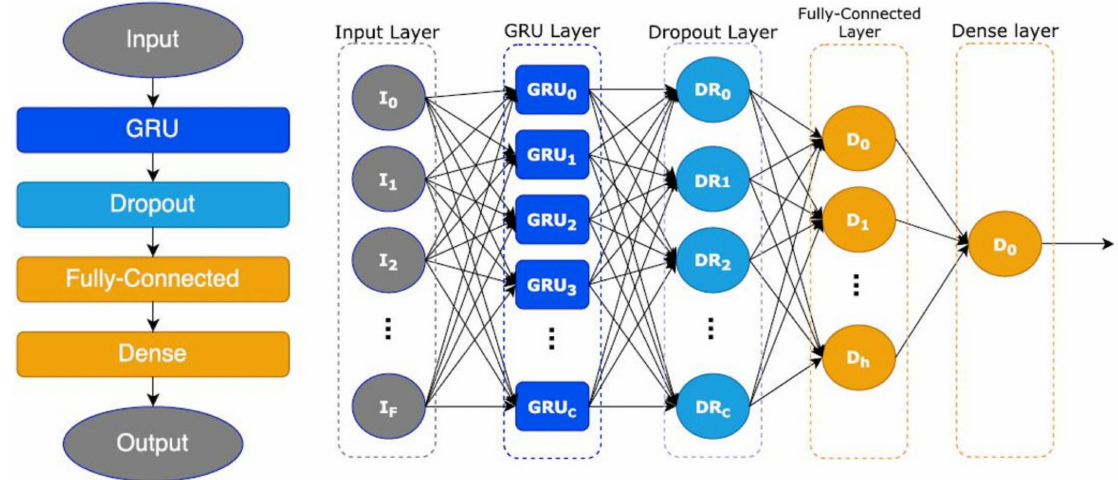
Figure 6. The proposed method of GRU (Assis, M. V, ELSEVIER, 2021).